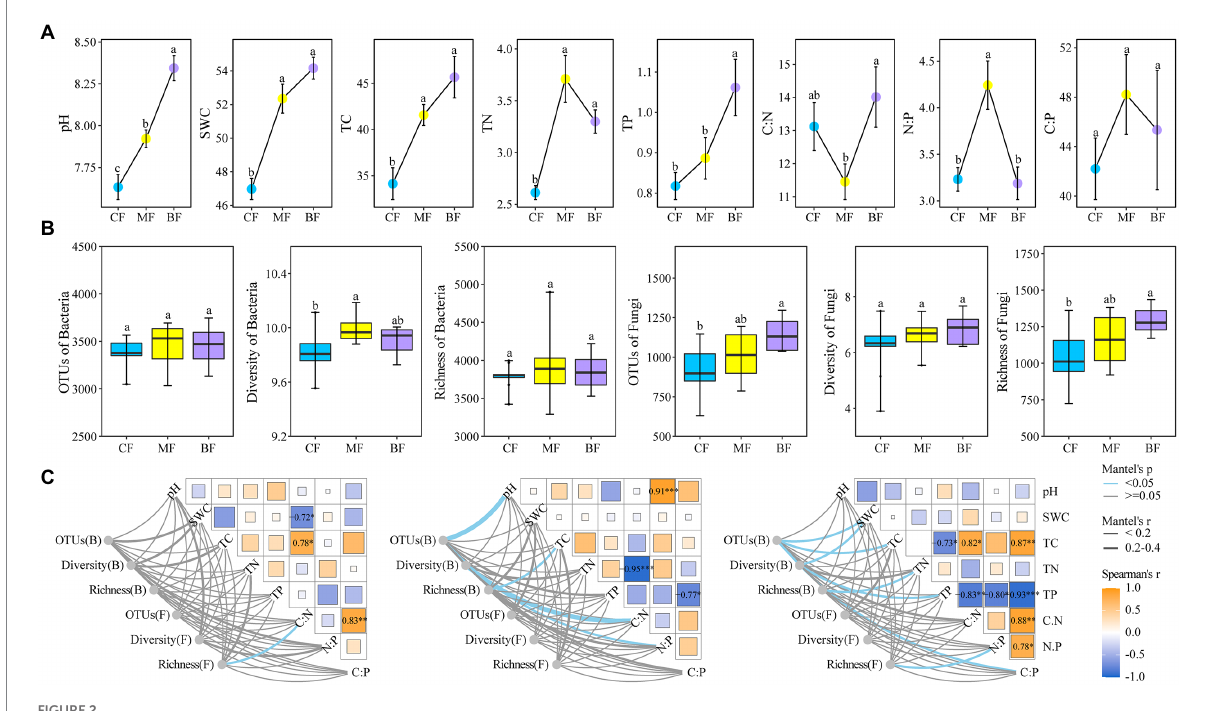
FIGURE 2 Soil physicochemical properties (A) , bacterial and fungal diversity (B) and their correlation (C) under forest stand differences. SWC, soil water content; TC, total carbon; TN, total nitrogen; TP, total phosphorus; OTUs, number of observed OTU. Diversity: Shannon index. Richness: ACE index. Values are mean ± standard errors ( n = 9). Columns with different letters indicate significant differences at p < 0.05 (Duncan test). Pairwise comparisons of environmental factors are shown with a color gradient denoting Spearman’s correlation coefficient. CF , coniferous forest; MF, mixed forest; BF, broad-leaved